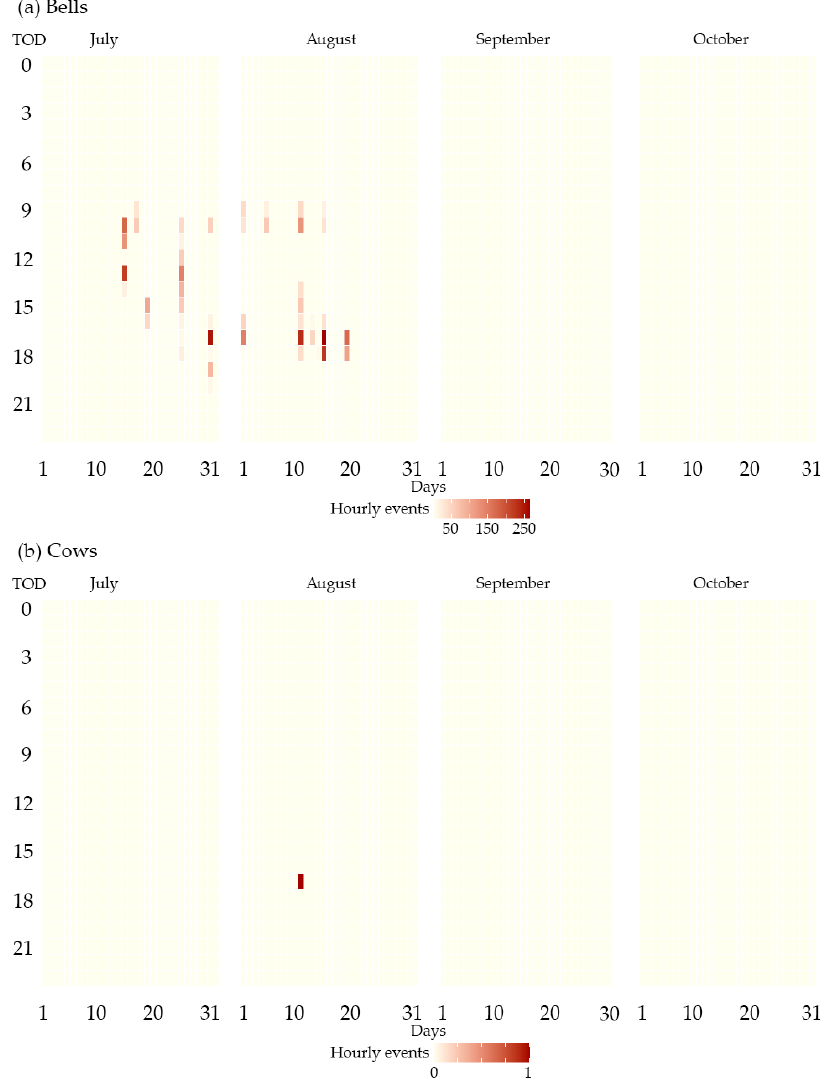
Figure 4. Diel and seasonal distribution of livestock bells ( a ) and cow lowing ( b ) at Plakes site. Y-axis rows represent time of the day (TOD; 0 am to 23 pm). X-axis columns represent days of the study period (1 July to 31 October).